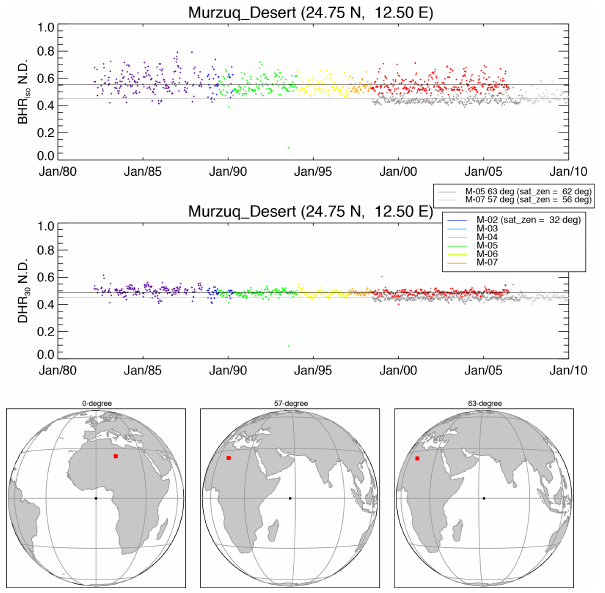
Figure 1. Long-term time series of BHR iso (upper panel) and DHR (middle panel) for the Murzuq Desert site. The position of the target site on the respective 0 ◦ and IODC field of view is shown in the bot- tom panel. The coloured dots refer to 0 ◦ coverage, the grey dots to IODC coverage. The dark and light-grey lines show the long-term averages for the two coverages. The spectral to broadband conver- sion coefficients from Loew and Govaerts (2010) have been applied.